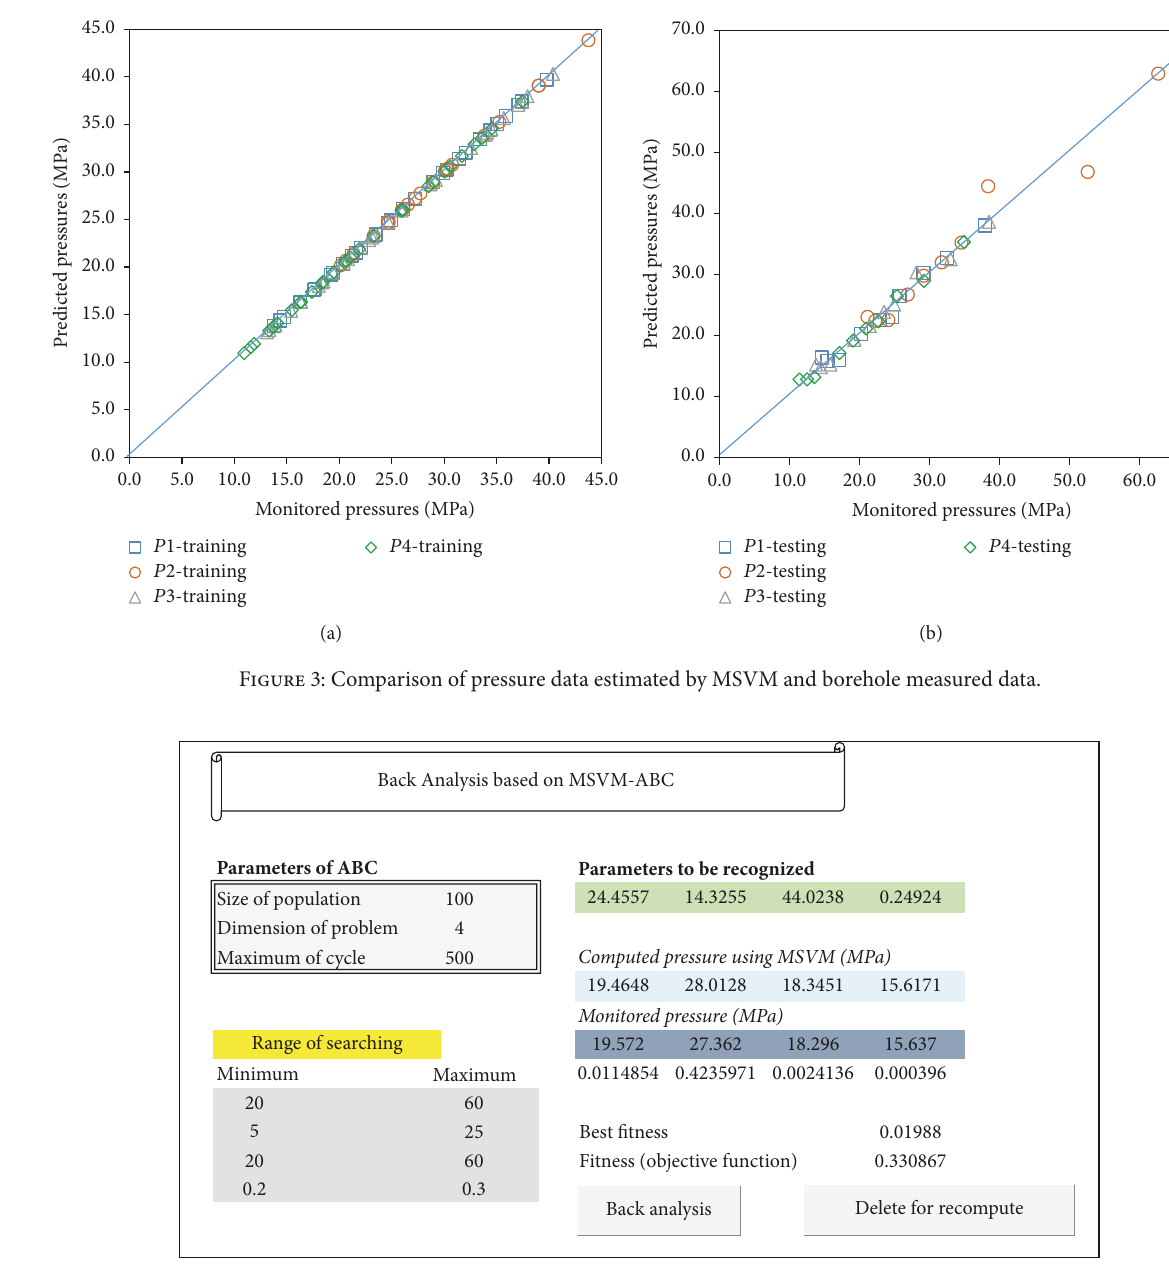
Figure 4: MSVM-ABC-based back analysis, its parameters, and results in the Excel VBA